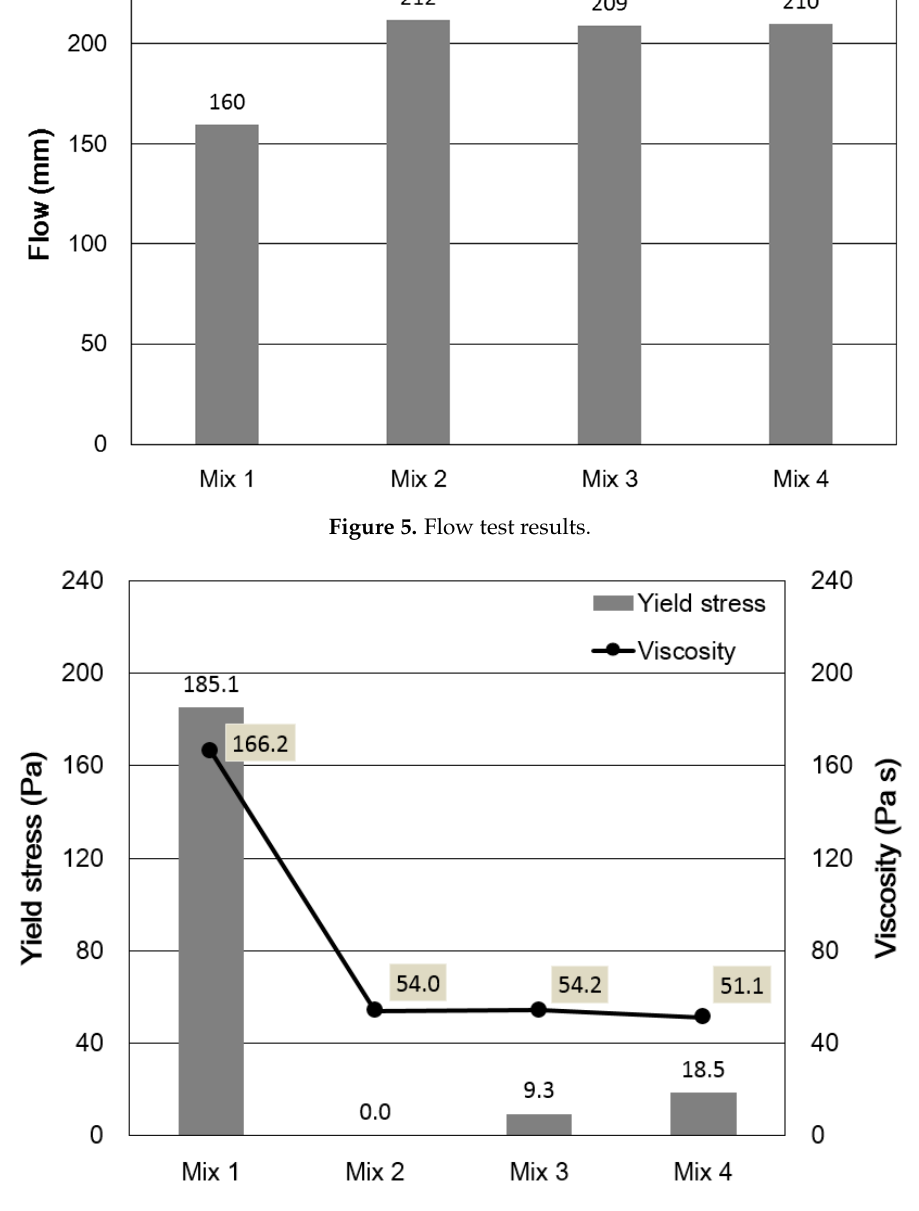
Figure 6. Yield stress and plastic viscosity estimated from rheometer test.